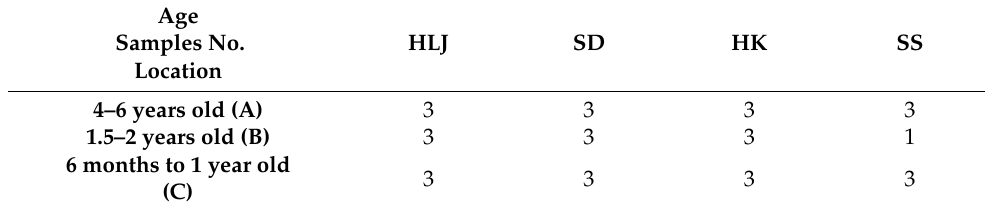
Table 1. The total number of fecal samples collected, stratified for area and cattle age. Age Samples No.